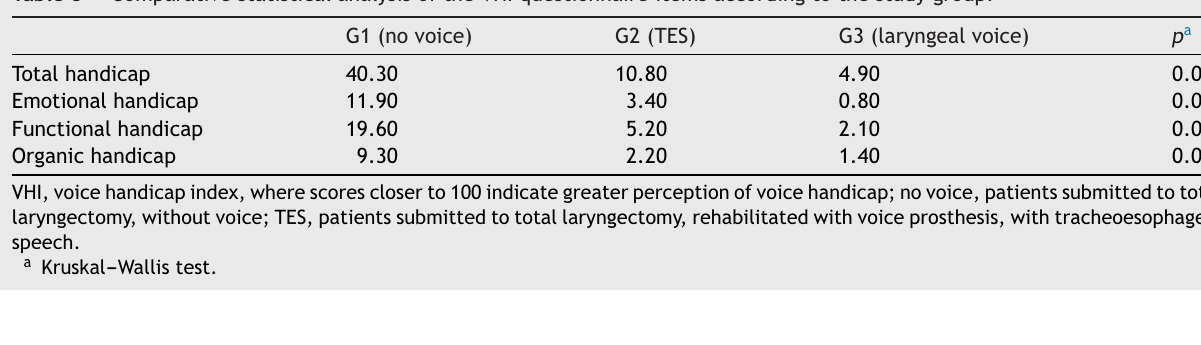
Comparative statistical analysis of the VHI questionnaire items according to the study